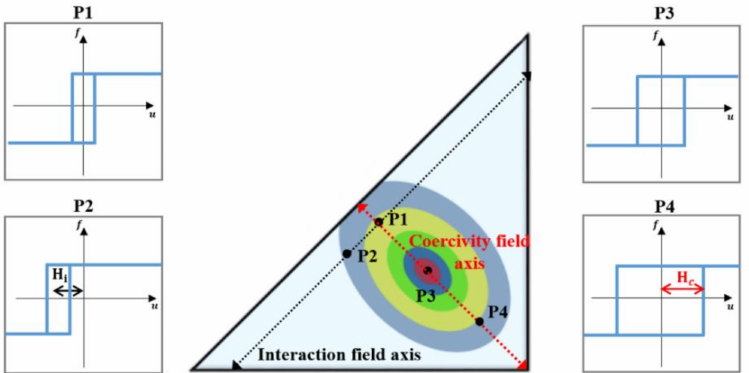
Figure 5. Preisach density distribution depending on coercivity and interaction fields on the Preisach plane.